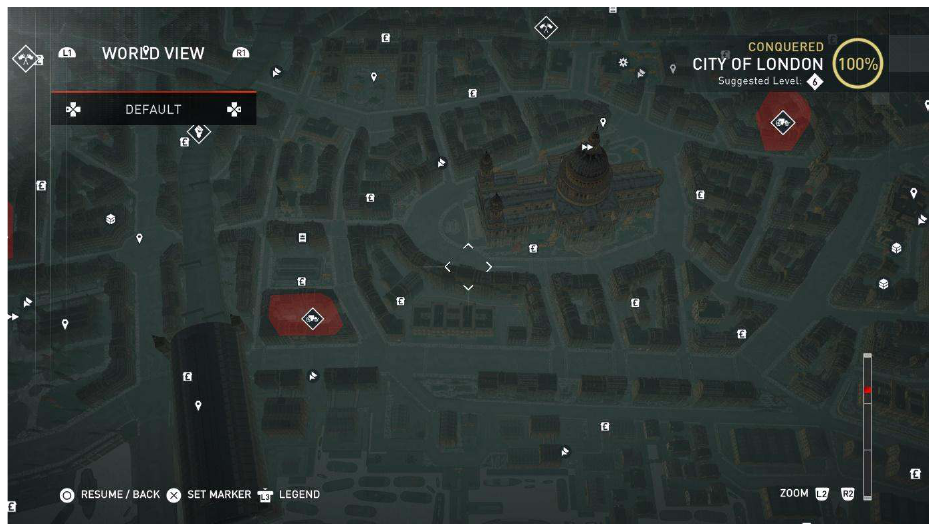
Figure 5: The game map annotated with the different objectives discovered by the player. Here around St Paul's Cathedral